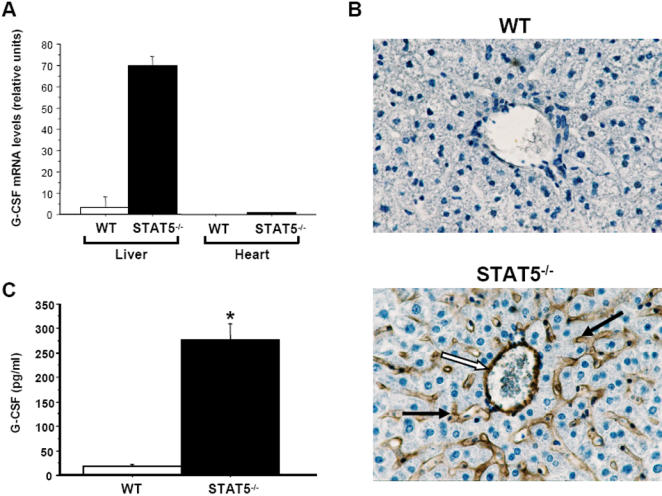
STAT5−/− LECs produce high amounts of G-CSF.(A) Elevated G-CSF mRNA expression in the liver of STAT5−/− mice. Liver and heart from wild-type (WT) and STAT5−/− mice were assayed for G-CSF mRNA expression by real time quantitative RT-PCR. All values are normalized to β–actin mRNA. No G-CSF mRNA was detected in WT heart. (B) LECs are the source of G-CSF in STAT5−/− mice. Liver sections from WT and mutant mice were stained to detect G-CSF (brown). Both endothelial cells lining the central vein (open arrow) and sinusoidal endothelial cells (solid arrow) stained for G-CSF. Original magnification, 250×. (C) STAT5−/− LSECs autonomously produce high quantities of G-CSF. WT and STAT5−/−LSECs were isolated, seeded onto 6-well flat-bottom plates at a density of 5×106 cells/well, and cultured for 3 days after which the medium was refreshed. Supernatants were harvested 6 hr later and analyzed for G-CSF concentration by ELISA. *, significantly different from WT values with P<0.05.